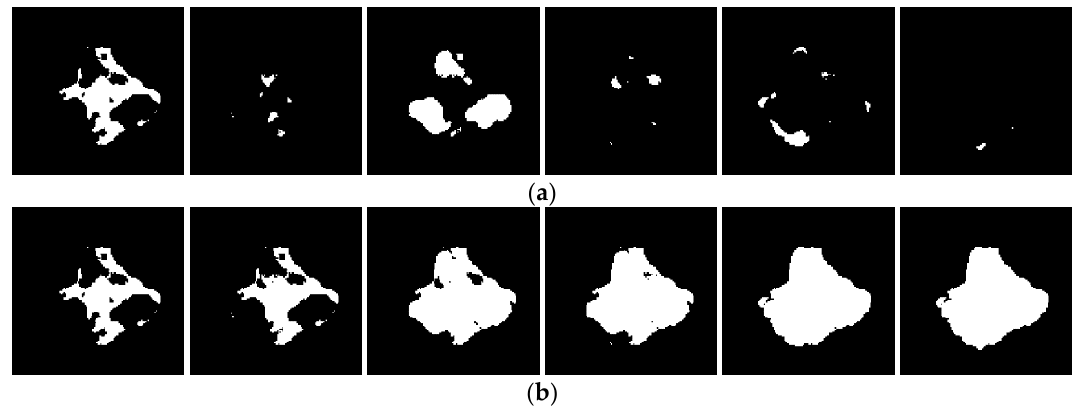
Figure 12. Detected damage layers at depths of, respectively: 0.51 mm, 0.78 mm, 0.94 mm, 1.25 mm, 1.37 mm, 1.92 mm: ( a ) based on the original result; ( b ) based on the filled result.